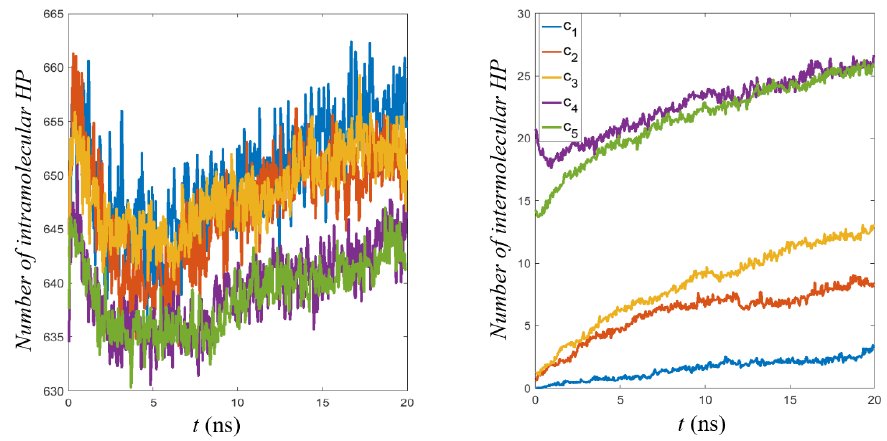
Figure 7. Number of hydrophobic contacts per single mucin molecule. Two cases are presented: ( left ) intramolecular; ( right )